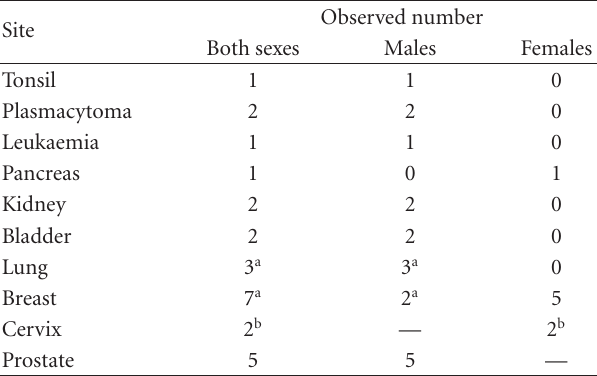
Table 3: Observed number of cases of noncutaneous malignancies in CM